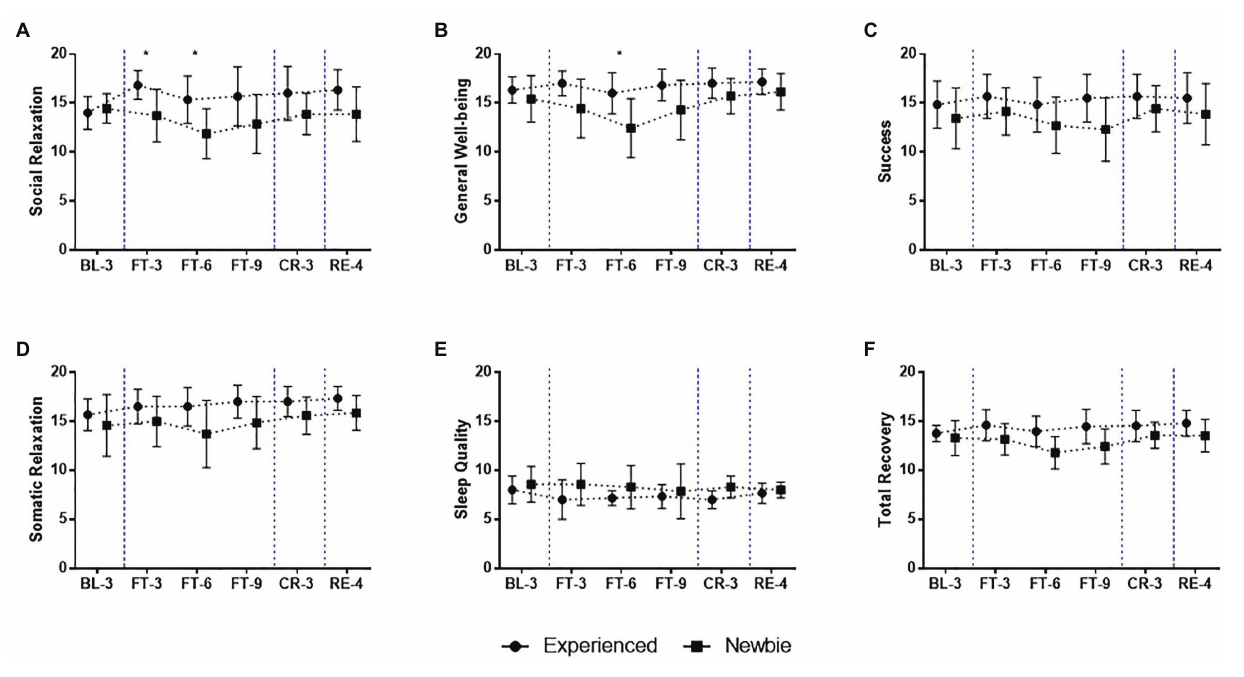
FIGURE 7 | Mean and SD of subscales of Recovery scores over the 22-day experiment for the Experienced and Newbie groups. (A-F) The scores of the subscales related to the stress in the recovery-stress questionnaires (RESTQ). Symbols represent mean scores for the two groups, and error bars represent the SD of the mean. * p < 0.05 indicates significant differences between the two groups at a given test point. Blue dashed lines indicate the different